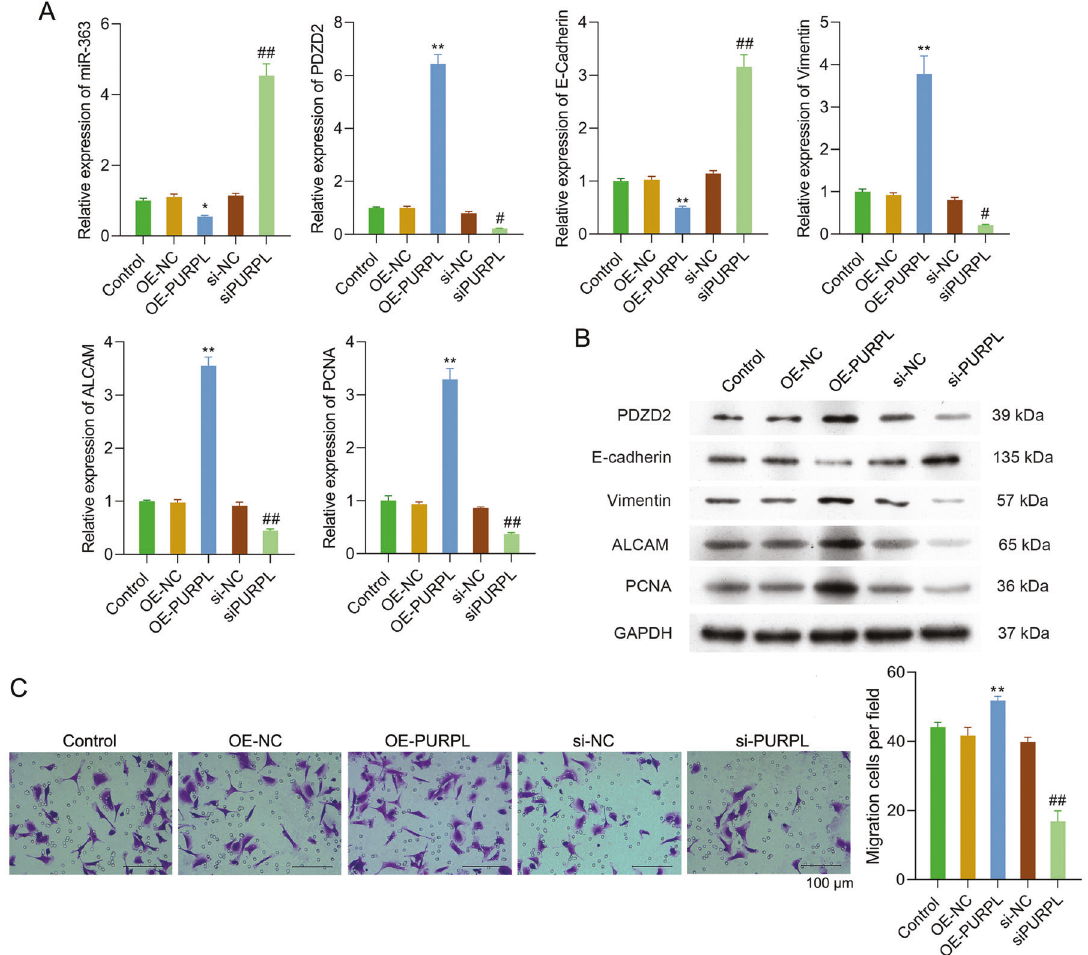
PDZD2, E-cadherin, vimentin, ALCAM, and PCNA were measured using western blotting. C TAMs were cultivated into the above chamber, while MG-63 cells were put into the below chamber. Forty-eight hours later, the migration of TAMs was tested. *P < 0.05, **P < 0.01 vs. OE-NC group. # P < 0.05, ## P < 0.01 vs. si-NC